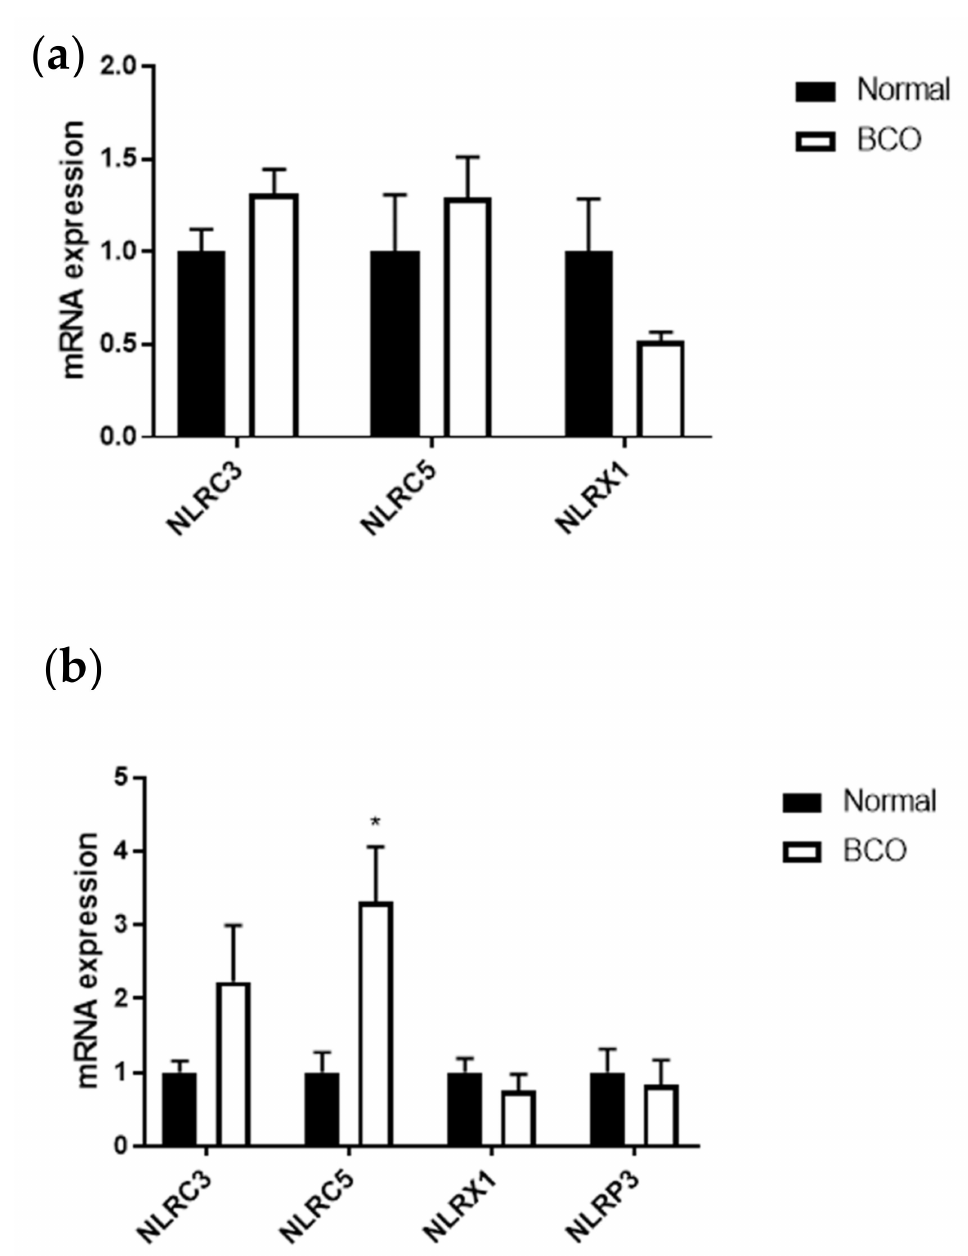
Figure 4. Local and systemic inflammasome profile in normal and BCO-affected broilers. Gene expression for NLRC3 , NLRC5 , and NLRX1 in bone ( a ) and blood ( b ) of normal and BCO-affected broiler chickens, as well as the expression of NLRP3 in blood ( b ). Significance was determined using a student t -test with p -value < 0.05. * indicates a significant difference between normal and BCO. 3.4. Key Receptor in the FGF23 Pathway was Significantly Downregulated in BCO-Affected